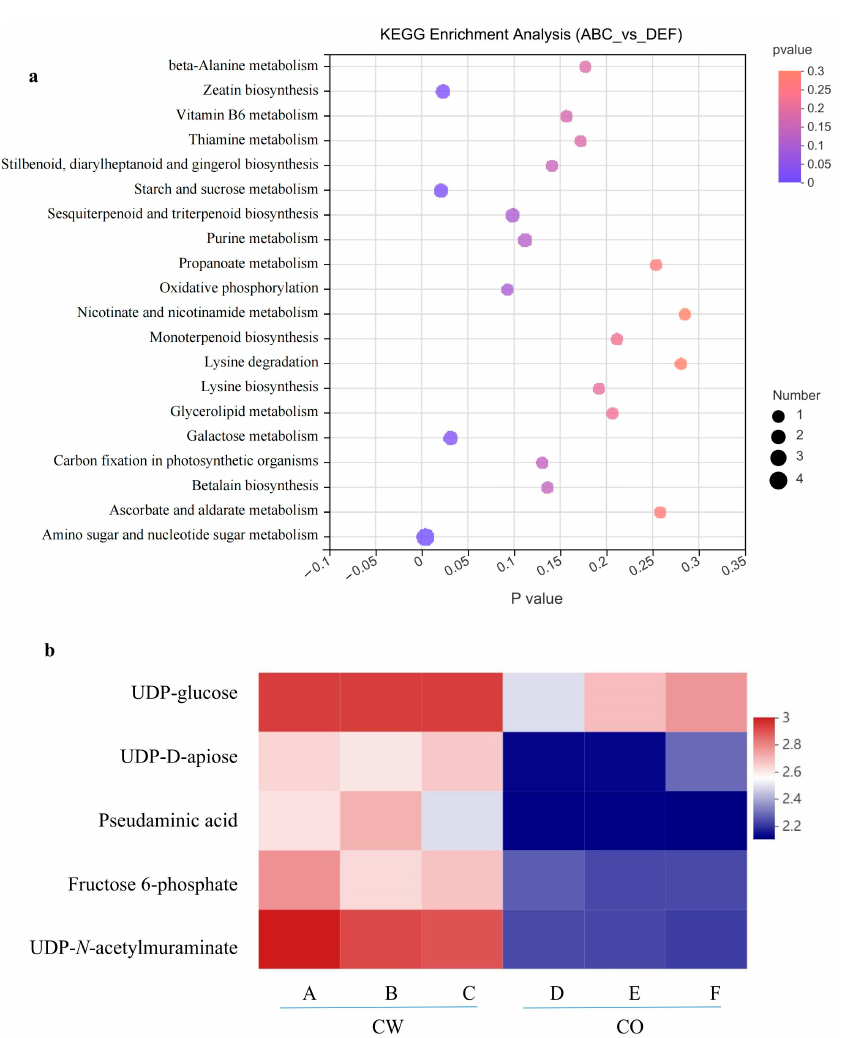
Figure 8. Metabolic pathway analysis of metabolites between two Camellia species. ( a ) KEGG pathway enrichment analysis of SCMs between CW and CO under different temperatures. The sizes of the dots represent the number of SCMs included in each row (KEGG pathway), and p values were calculated from hypergeometric tests; ( b ) heat map of key SCMs associated with sugar metabolism. The heat map was generated from the log2 (abundance values). Changes in abundance level are represented by a change in color; blue indicates a lower abundance level, whereas red indicates a higher abundance level. CW, Camellia weiningensis ; CO, Camellia oleifera ; A, CW treated with 20 °C; B, CW treated with 4 °C; C, CW treated with − 4 °C; D, CO treated with 20 °C; E, CO treated with 4 °C; F, CO treated with − 4 °C.